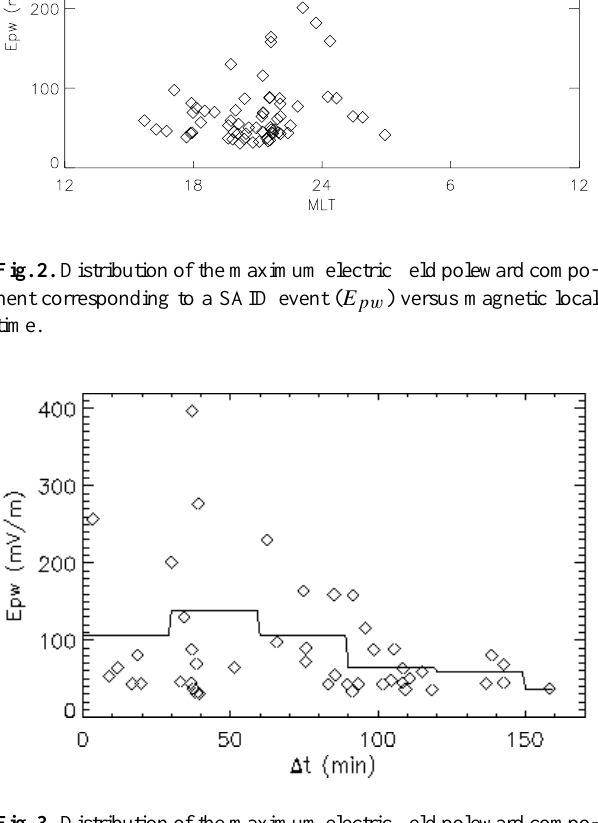
Fig. 5. Distribution of the potential drop measured across a SAID structure versus time after substorm onset ( 1t ). The solid line rep- resents the average potential drop calculated over 30-min